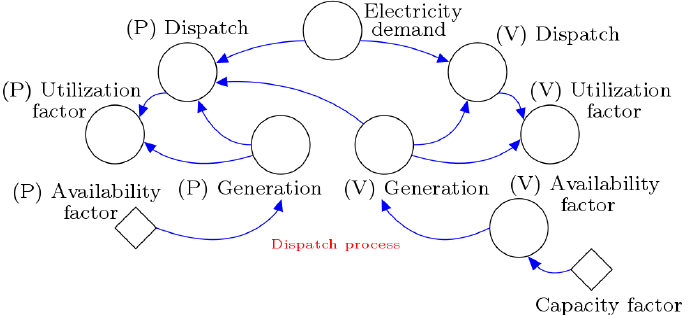
Figure 5. Electricity dispatch as in [13,14]. Note that the (V) availability factor is the same variable of Figure 7 called af v . This variable connects the electricity dispatch with the ENSO phenomenon. Reprinted with the permission of Reference [13]. Copyright 2018